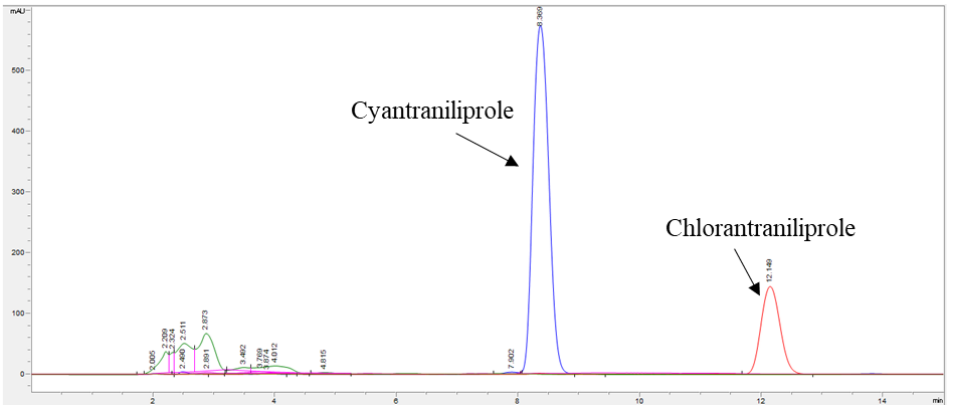
Figure 4. Chromatograms overlay in HPLC of two pesticides standards, cyantraniliprole (at 8.4 min) and chlorantraniliprole (12.3 min), and other pesticide-free samples of soil, leafy parts of lettuce, and root parts metrics (before 6 min) with constant flow (1mL/min) of 45% Acetonitrile in DW as mobile phase.